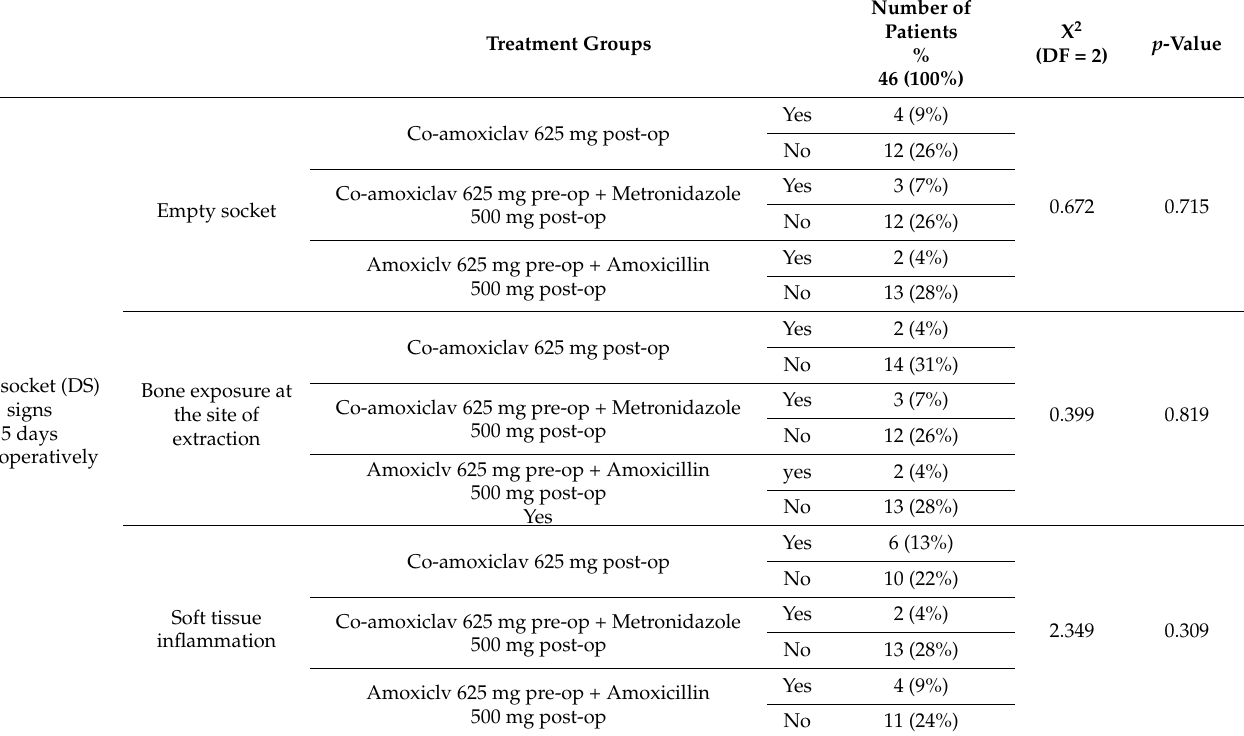
Table 1. Comparisons of the total incidence of dry socket signs for the patients in the co-amoxiclav, co-amoxiclav plus metronidazole and co-amoxiclav plus amoxicillin groups 5 days post-operation. Treatment Groups